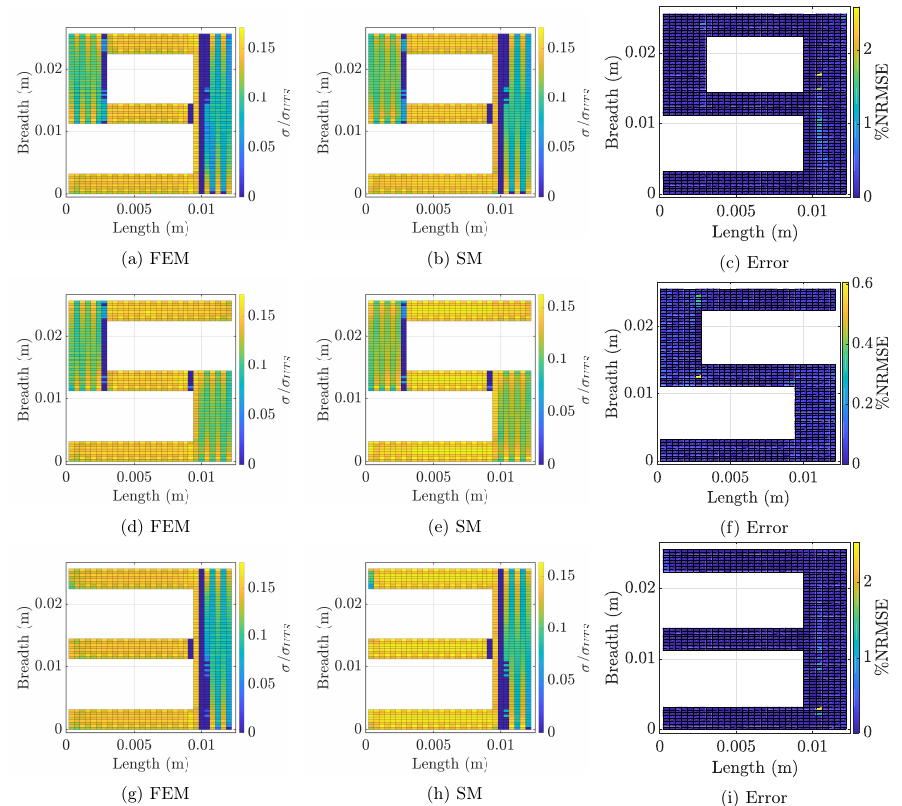
Figure 7: Comparison of the predictive power of the SM for complex geometry. The left panel depicts the Figure 7. Comparison of the predictive power of the SM for complex geometry: ( left ) the distribution distribution of the consolidation degree predicted using physics based simulation. The right panel depicts the of the consolidation degree predicted using physics based simulation; and ( right ) the consolidation consolidation degree predicted by the SM. degree predicted by the